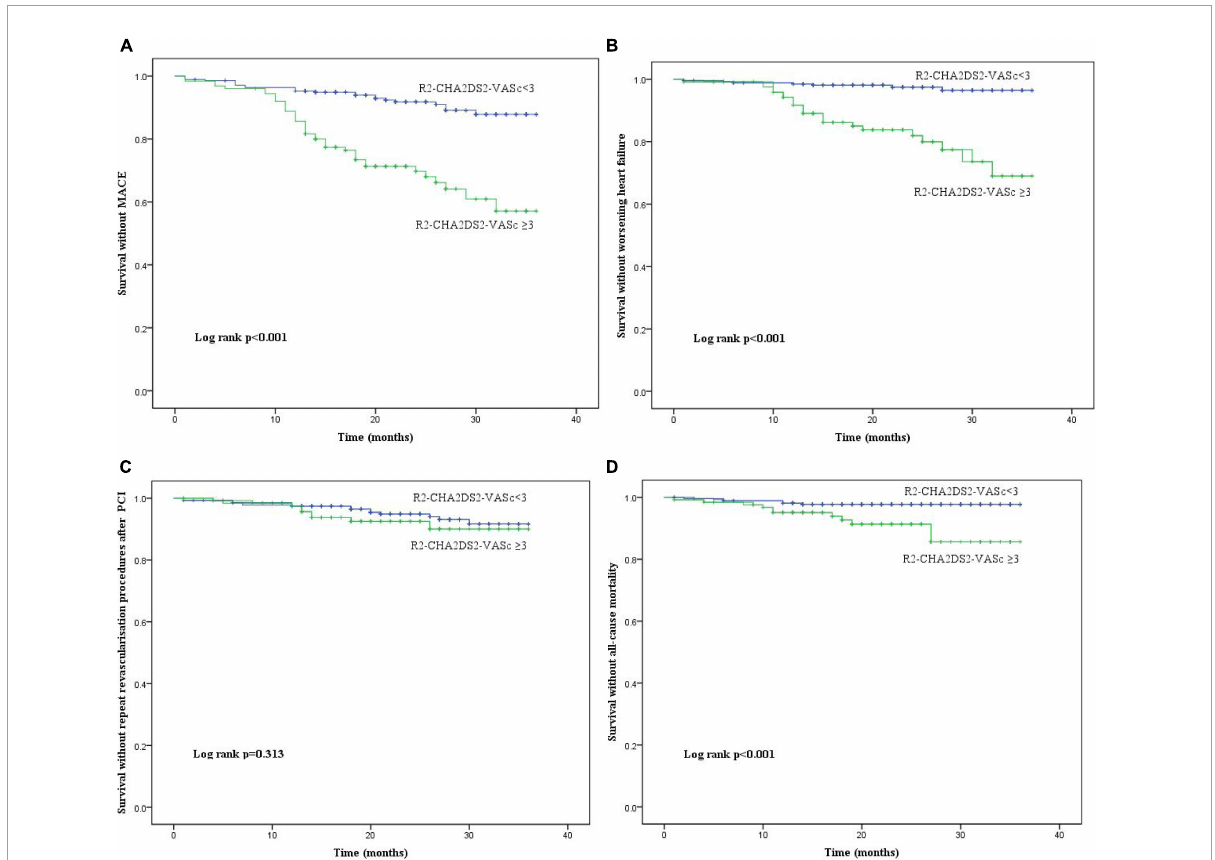
FIGURE2 The Kaplan-Meier curves of the cumulative incidence of (A) MACE, (B) worsening heart failure, (C) repeated revascularisation procedures after PCI and (D) all R 2 -CHA 2 DS 2 -VASc score groups. MACE, major adverse cardiac events; PCI, percutaneous coronary intervention.